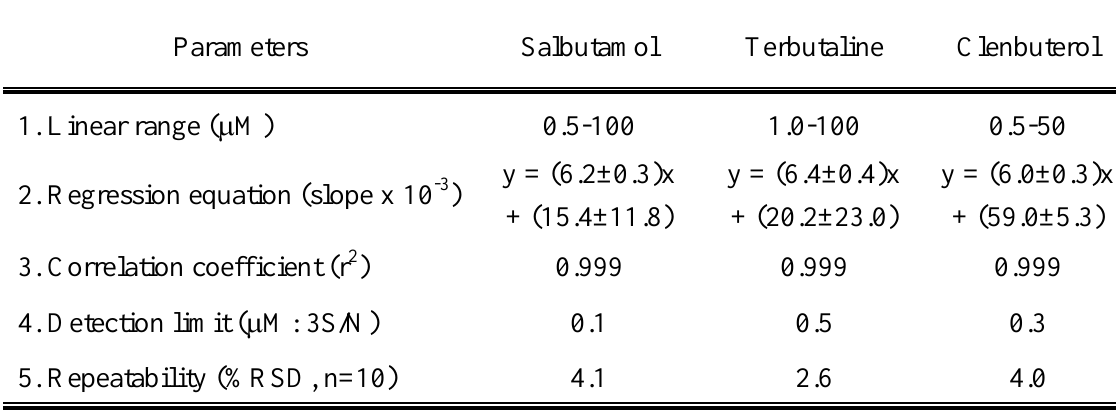
Table 2. Analytical features of the developed flow injection method, with PAD on boron-doped diamond for analysis of β -agonists.